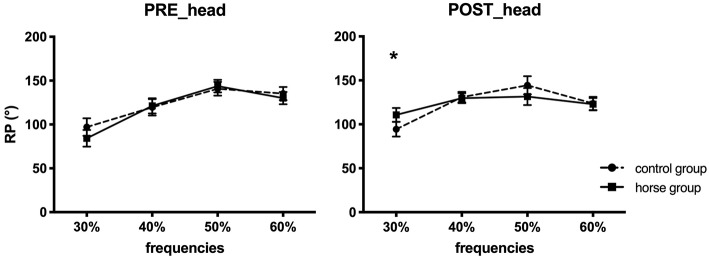
Depiction of relative phase (mean ± standard error) of head/horse coordination in the pre- and post-tests, for the control group (dashed line) and the horse group (continuous line). *Represents significant differences.